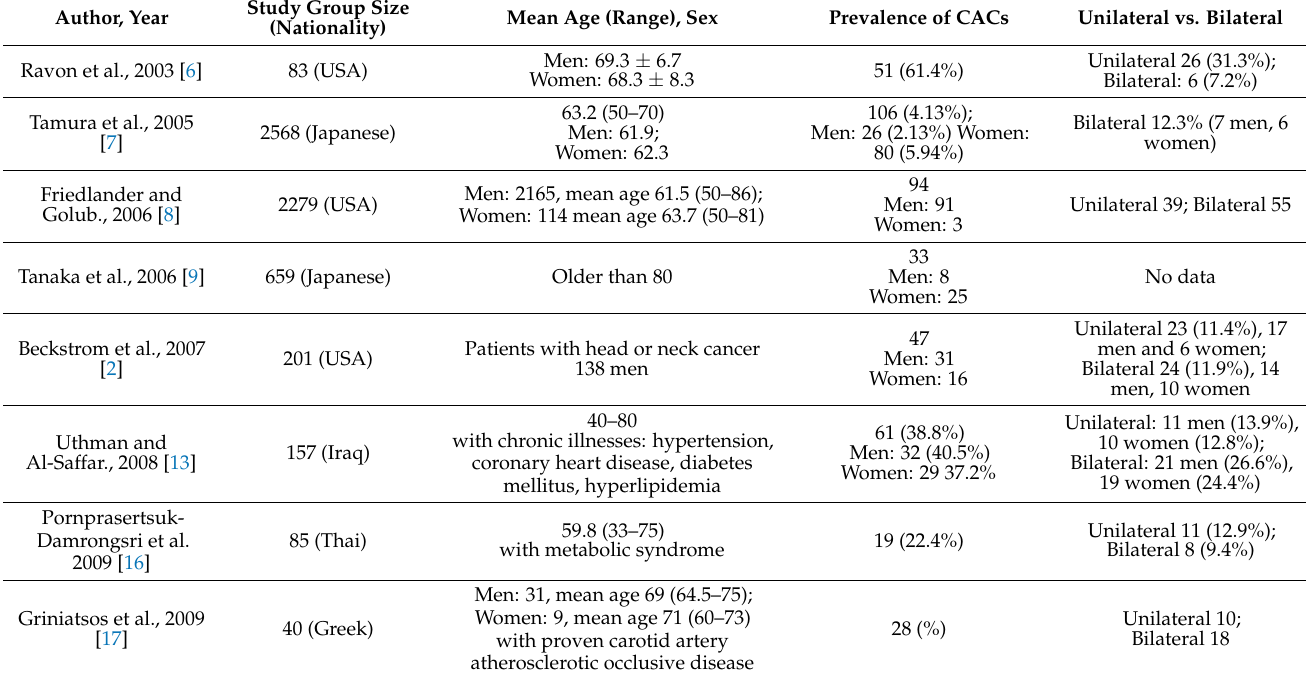
Table 2. Studies on prevalence of carotid artery calcifications (CACs) on panoramic